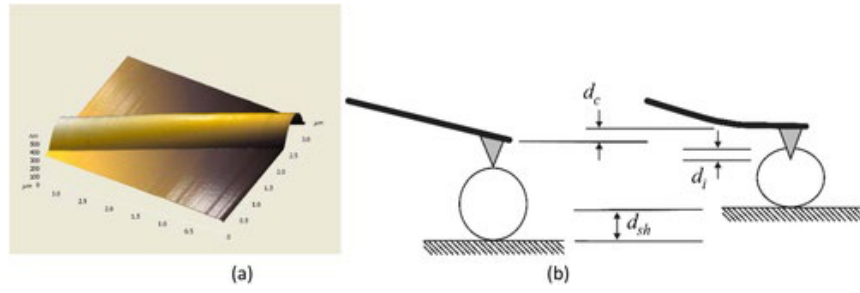
Figure 15. ( a ) Indentation test of a single nanofiber on a solid silicon. ( b ) A schematic explaining the deformation process in AFM measurement: before deformation (left) and after deformation (right). Reprinted from [113, 127] with permission from John Wiley and Sons.